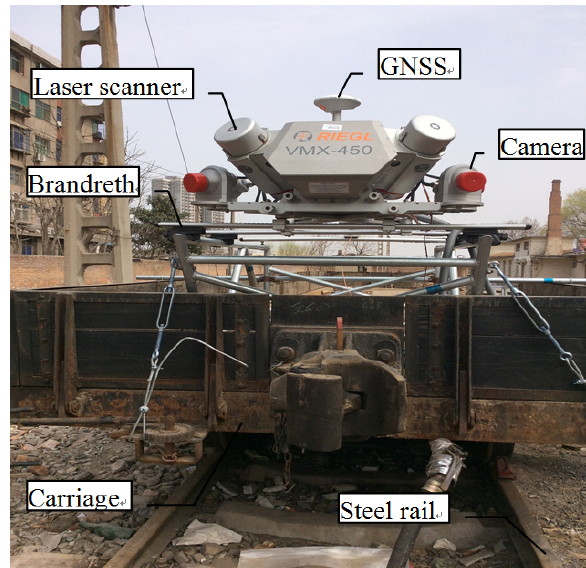
Figure 1. RIEGL VMX-450 system